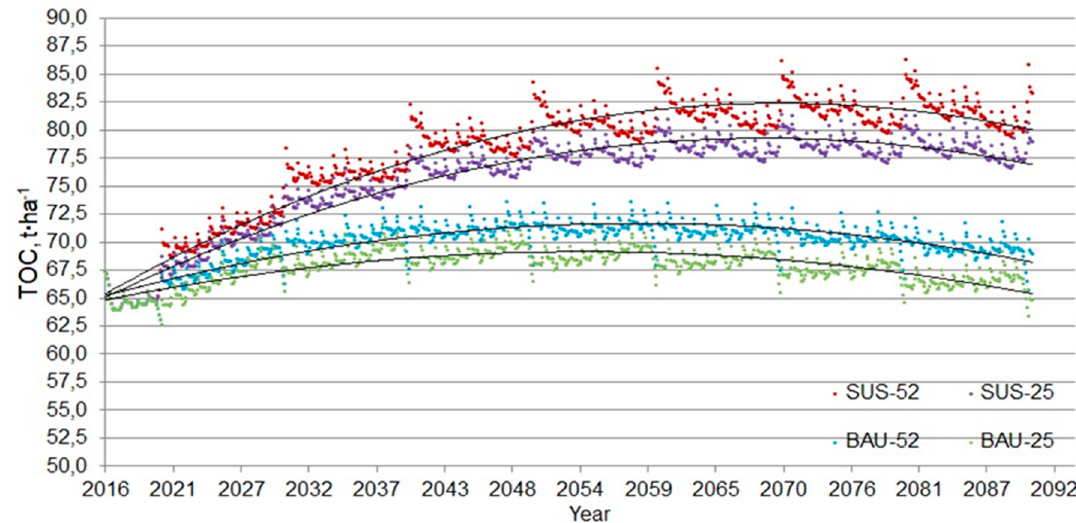
Figure 10. The dynamics of total SOC stock for various crop rotations calculated by the RothC model for 2016–2090 in 1 NPK treatment under the RCP8.5 climate scenario. The trend line is a polynomial of the second